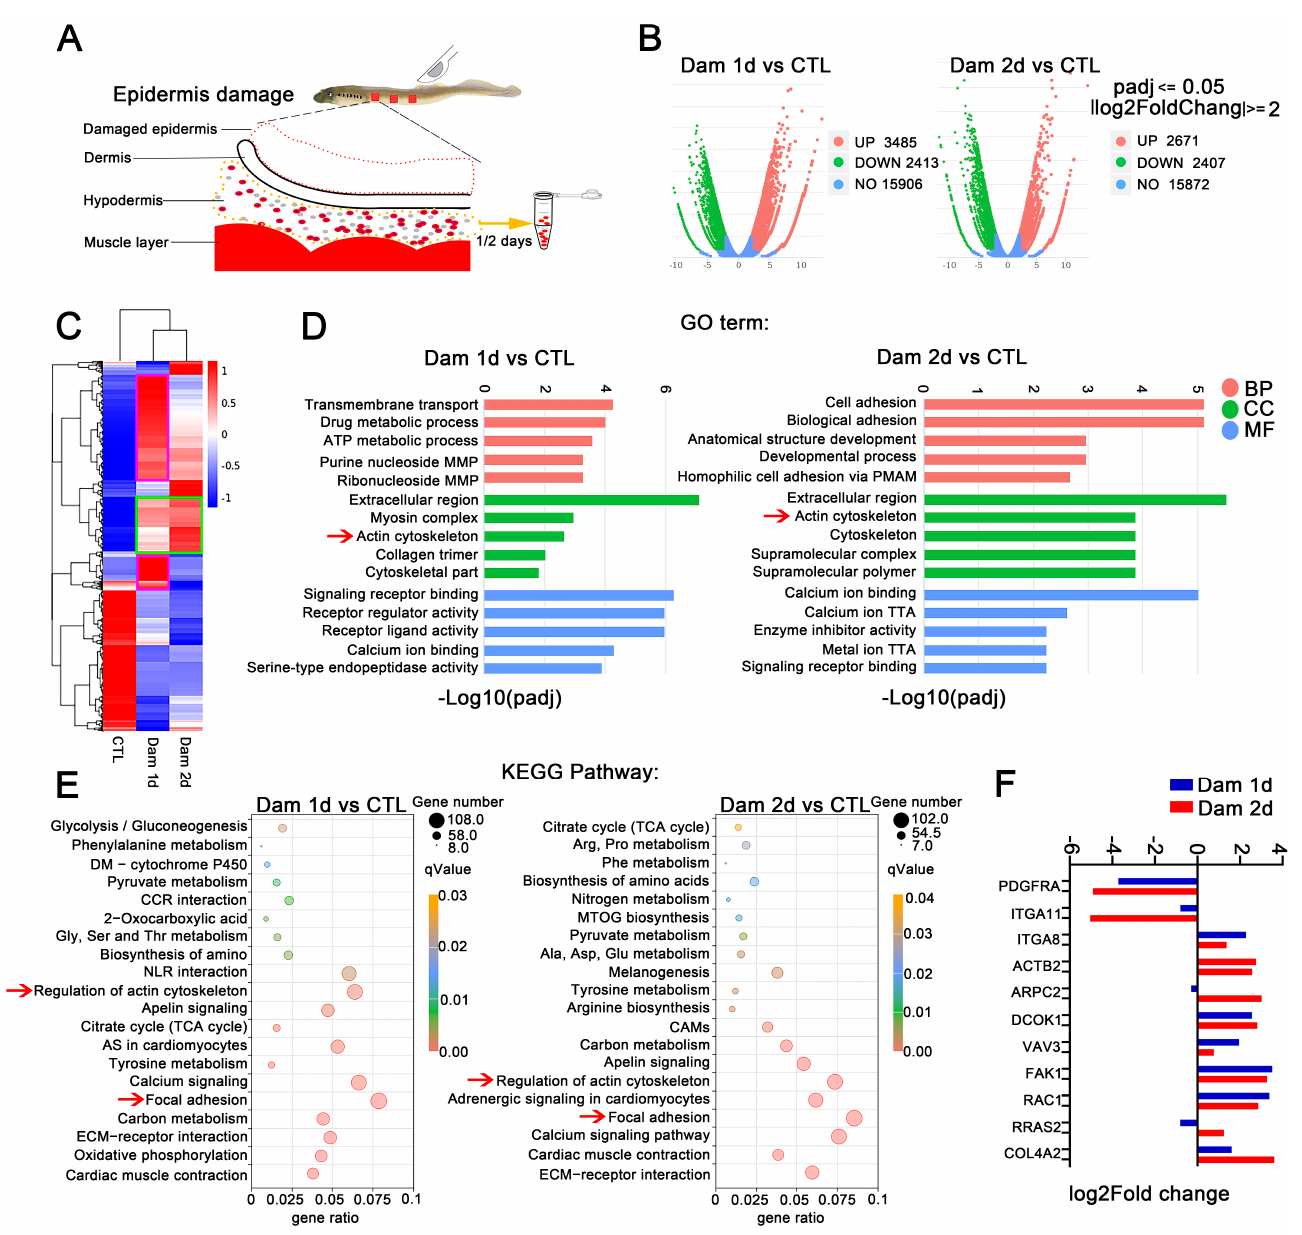
Figure 4. RNA-seq analysis of the hypodermis after epidermal damage. ( A ) Schematic diagram of hypodermis transcriptome sampling after epidermal damage. ( B ) Volcano plot of the differentially expressed genes (DEGs) in lampreys after skin damage. ( C ) Cluster expression analysis. Shared DEGs (green box) and unique DEGs (purple box) were found at the two time points. ( D ) GO functional category analysis. ( E ) KEGG pathway classification analysis; the red arrow indicates major signaling pathways. ( F ) Expression of selected genes in the subcutaneous fat layer. MMP: monophosphate metabolic process; PMAP: plasma membrane adhesion protein; TTA: transmembrane transporter activity; DM: drug metabolism; CCR: cytokine − cytokine receptor; NLR: neuroactive ligand − receptor; AS: adrenergic signaling; CAMs: cell adhesion molecules; MTOG: mucin type O − glycan. The yellow arrow means to receive samples one day and two days later. The red arrow is to better notice the key signal pathway.